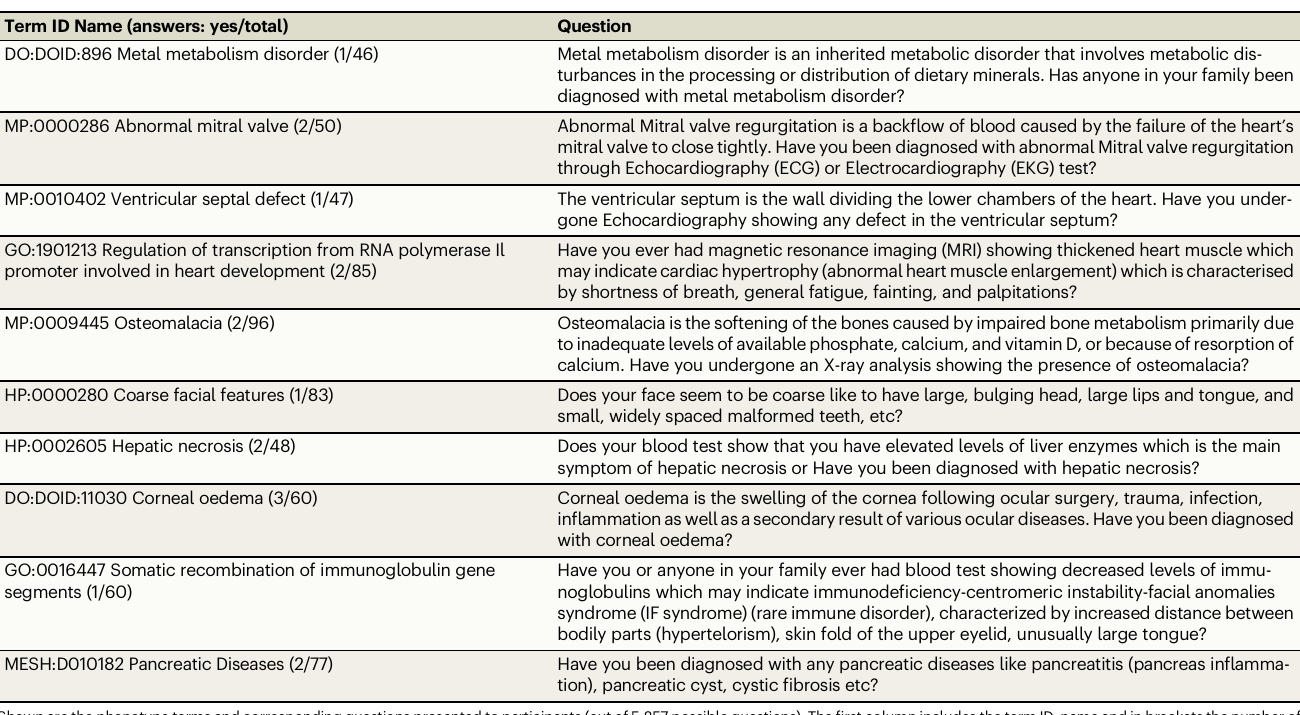
Table 1 | 10 representative examples of top DTC cohort phenotypes Term ID Name (answers: